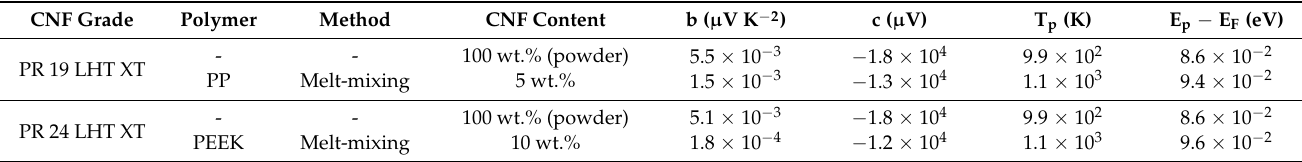
Table 5. Parameters b, c, T P and E P − E F obtained by Equation (3) of CNF powder and PP/5 wt.% CNF composites analysed in a previous study [32], and CNF powder and PEEK/10 wt.% CNF composites analysed in this